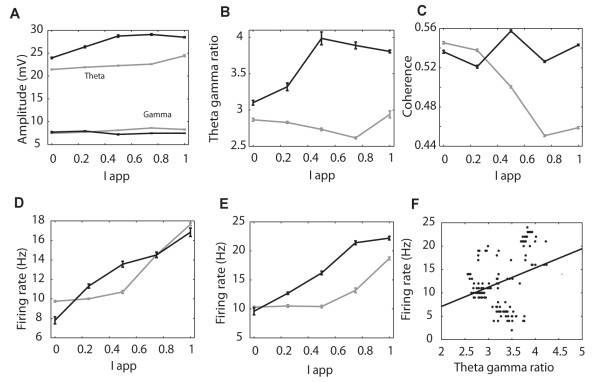
Learning effects produced in the model by altering NMDA receptor sensitivity. Graphs show changes (after learning = black; during learning = gray) in (A) Theta and gamma amplitude as a function of stimulus strength (Iapp). (B) Theta/gamma ratio, (C) Coherence between theta phase and gamma amplitude (D) Firing rate of the excitatory output neurons (E) Firing rate of the downstream neuron and (F) Positive correlation between downstream neuron firing rate and magnitude of the theta/gamma ratio (r = 0.34, P < 0.01). NMDA, AMPA and GABA A receptor coefficients after learning are the same as for shallow nested gamma in Figure 8B. For during learning NMee = 0.002 and NMes = 0.0001; after learning NMee = 0.0035 and NMes = 0.00055. Data are means ± sems from 10 averaged runs of the model. Taking an overall average across the different values of Iapp, t-tests revealed significant differences between before and after simulated learning in theta amplitude (A), t18 = 81.5, p < 0.0001; gamma amplitude (B), t18 = -12.1, p < 0.0001; theta/gamma ratio (C), t18 = 32.02, p < 0.0001; theta/gamma coherence (D), t18 = 2.6, p = 0.03; excitatory neuron firing rate (E), t18 = -2.23, p = 0. 04 and the firing rate of the downstream neuron (F), t18 = 13.6, p < 0.0001.